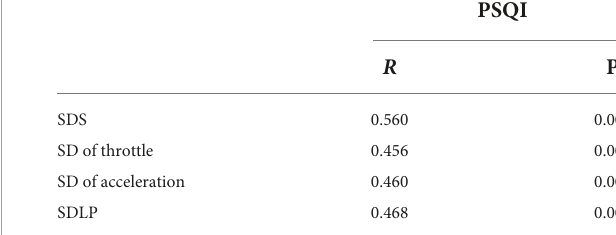
TABLE 2 Correlation between the PSQI scores and driving